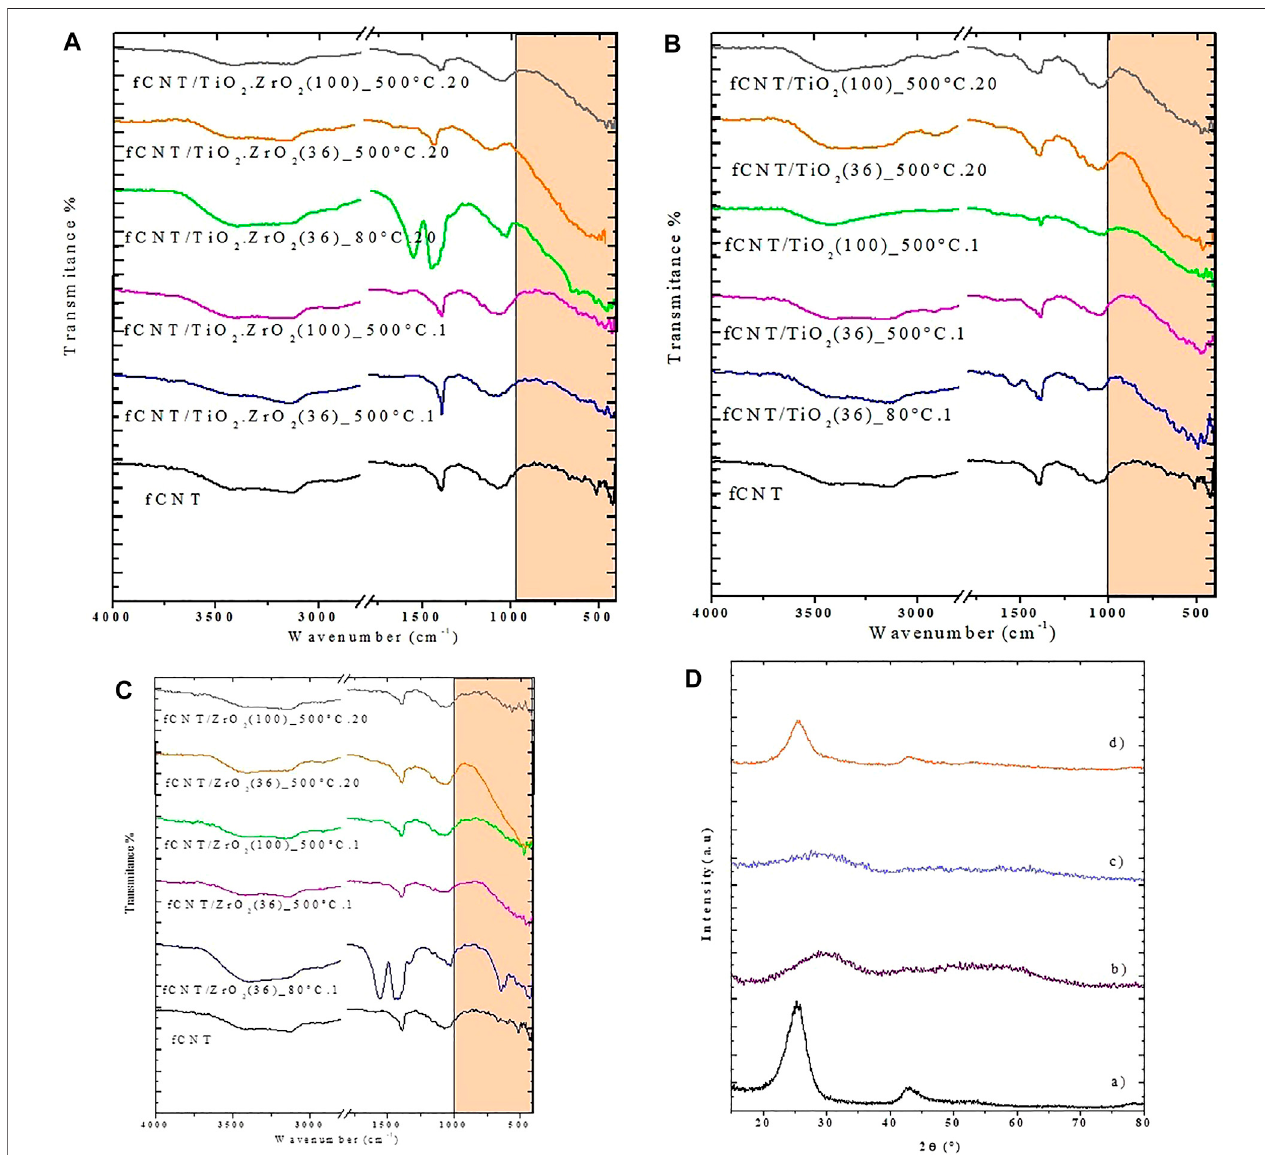
FIGURE1| FTIRspectraofthenanostructuredmaterialsobtainedunderdifferentsynthesisconditions: (A) fCNT/TiO 2 ZrO 2 ; (B) fCNT/TiO 2 ; (C) fCNT/ZrO 2 ;and (D) XRD patterns of a) fCNT, b) ZrO 2 80 ° C, c) TiO 2 - 80 ° C. and d) fCNT/TiO 2 (36) 80. ° C.1.